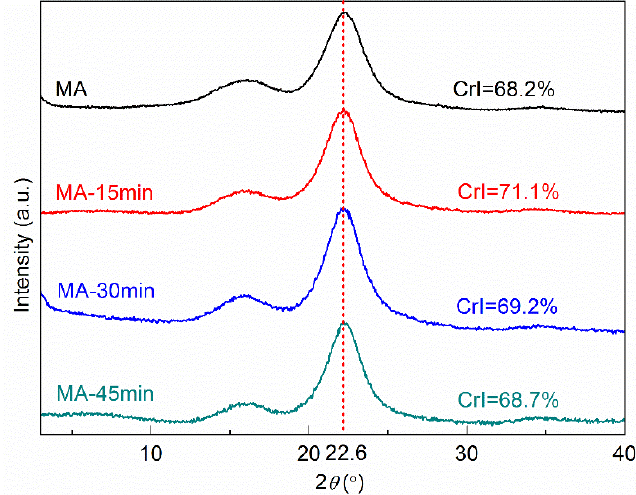
Figure 4. XRD profiles of the MA sample and the all-wood biocomposites with different hot-pressing times.